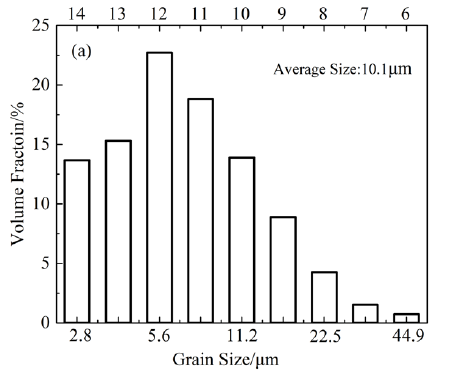
Figure 1. Microstructures of tested steel. ( a ) Cold rolled sample and ( b – e ) annealed samples at 710 °C, 730 °C, 760 °C and 780 °C respectively.